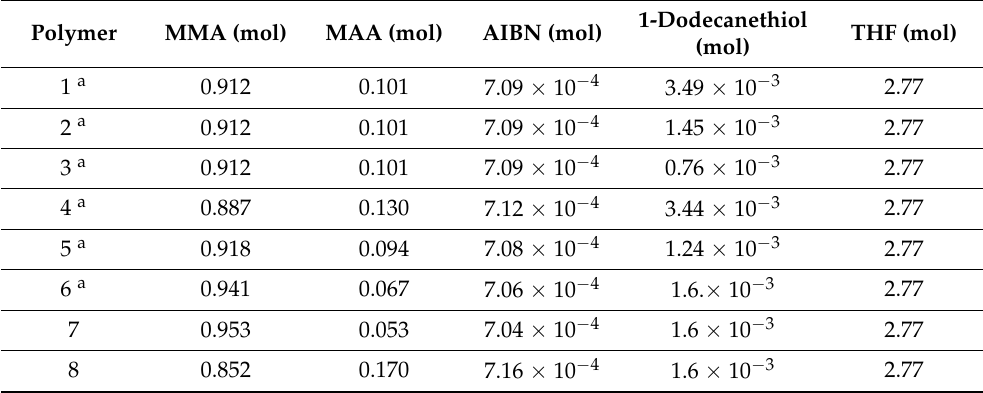
Table 1. Molar quantities of the monomers, initiator (AIBN), and chain transfer agent (1-dodecanethiol) that was used for the synthesis of polymers